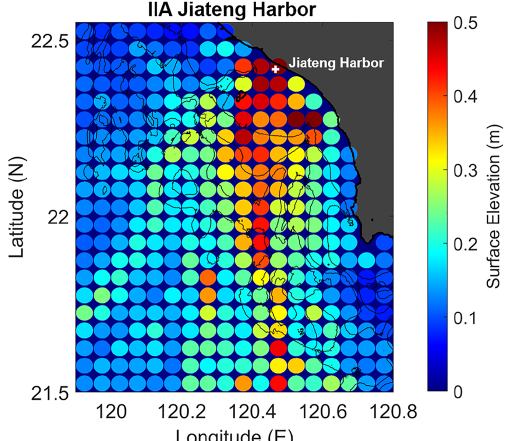
Figure 4. High-resolution IIA results of the Jiateng Harbor. The cir- cles represent the locations of unit-source tsunamis. Color denotes the value of maximum wave height recorded at the study site.